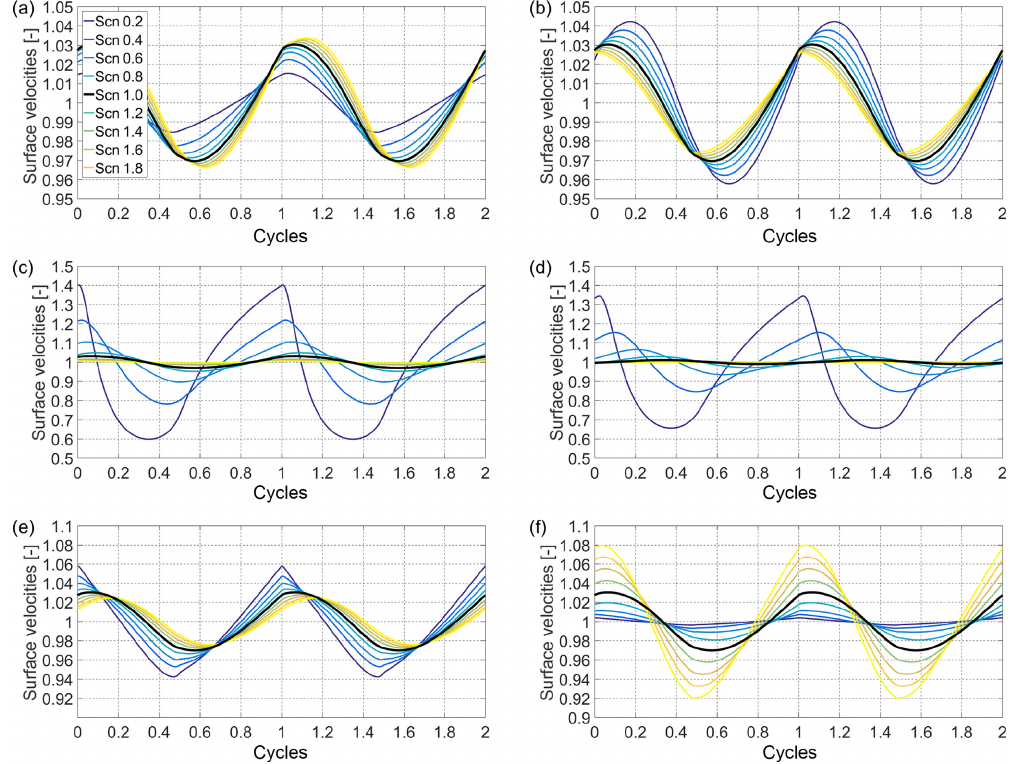
Figure 6. Results of the modelling sensitivity experiments of the model to (a) seasonal amplitude (winter minimum temperature), (b) bottom temperature, (c) thickness, (d) thickness with shear horizon, (e) volumetric ice content and (f) thermal diffusivity. The surface velocities normalised with their mean are plotted for each experiment with time, given here as the number of cycles (after the 28th cycle). One cycle corresponds to 1 year. For all experiments the different scenarios are colour coded as illustrated in the legend of panel (a) ; the reference scenario is plotted with a thicker solid black